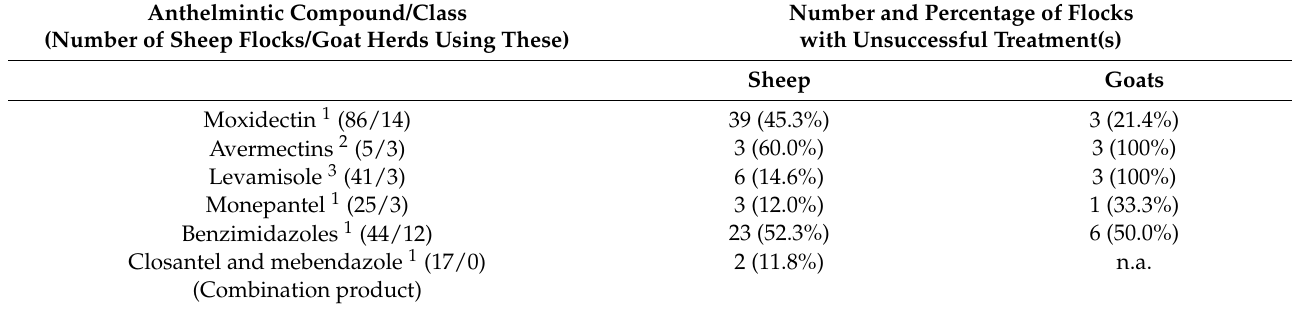
Table 3. Proportion and percentage of unsuccessful treatments (faecal egg count reduction [FECR] < 95%) in 223 small ruminant flocks performing 253 treatments, by anthelmintic com- pound/class. Treatments chosen and performed by farmers and their veterinarians. Pooled samples were used to assess FECR, and some farmers used different anthelmintics in different animal groups.